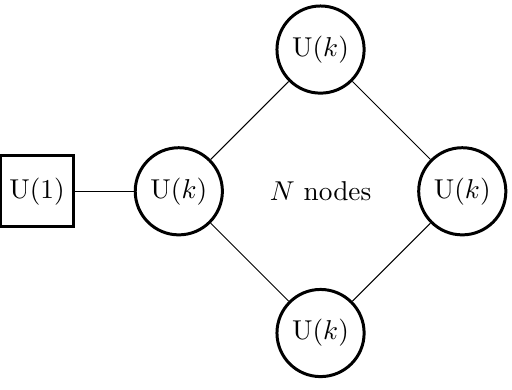
Figure 2 . Quiver de(cid:12)ning the ~ B N